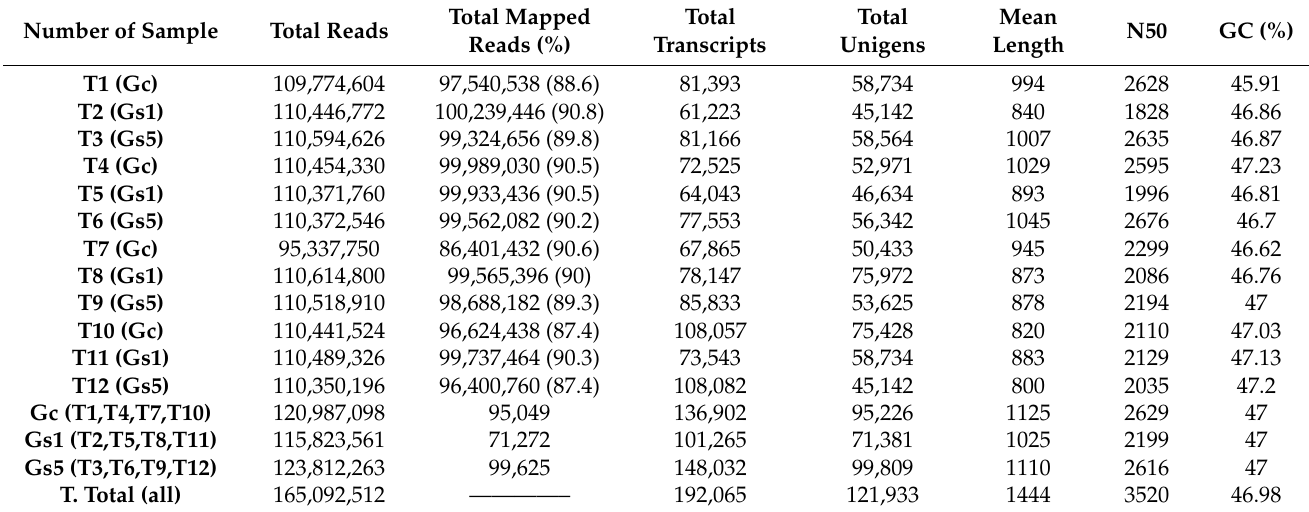
Table 1. Metric and quality of each of the individual samples, the three experimental groups (Gc, Gs1, and Gs5), and the complete transcriptomes of the loggerhead sea turtle, Caretta caretta . Number of Sample